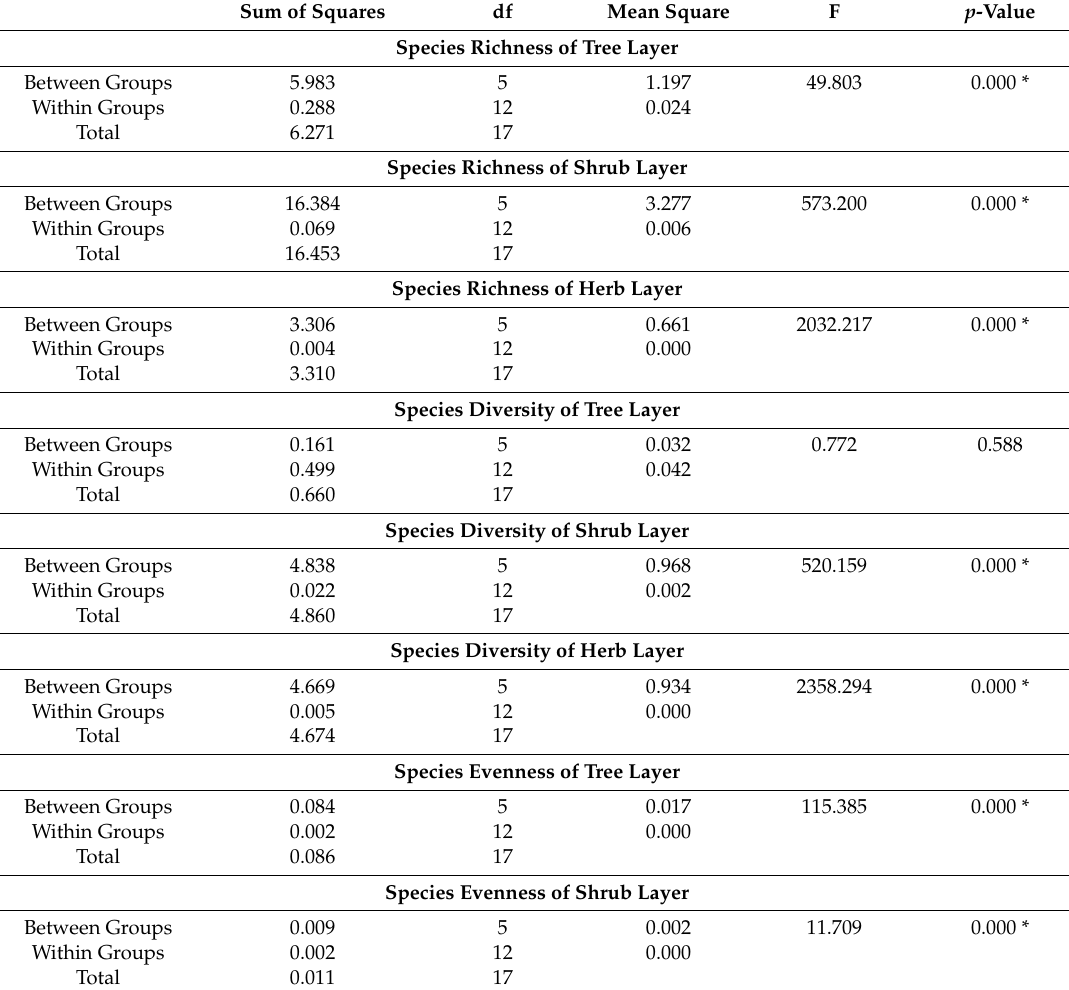
Table 3. ANOVA results on the impacts of harvesting intensity on diversity indices of various